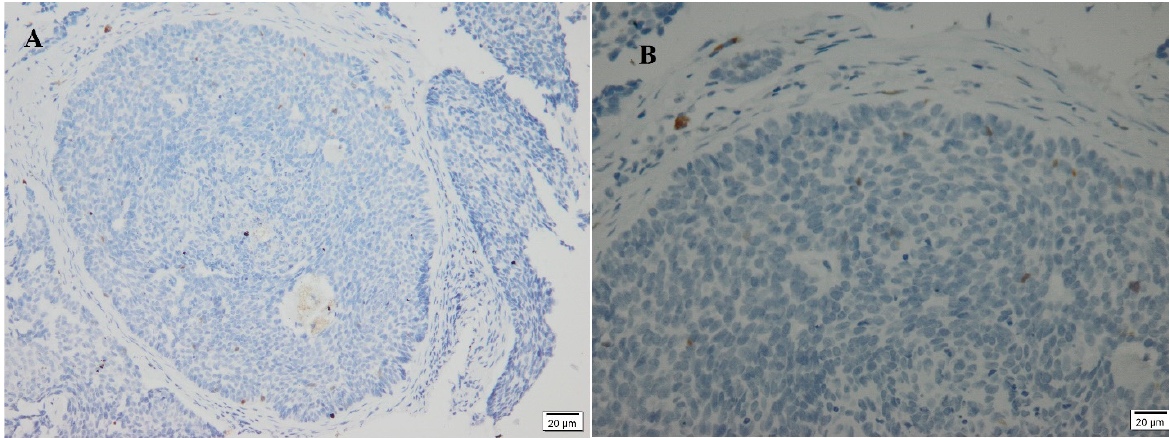
Figure 4. Negative immunostaining of p16 in two cases of BCC. ( A ) A case from a sun-exposed area (200×); ( B ) a case from a sun-protected area (400×).